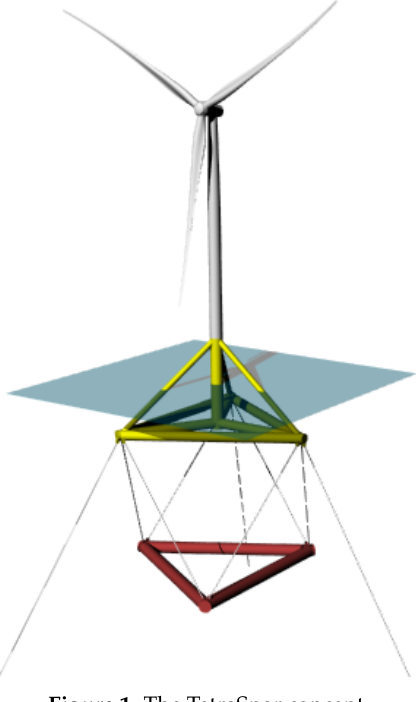
Figure 1. The TetraSpar